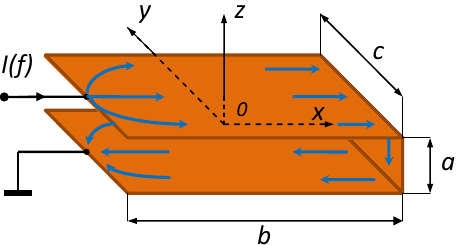
Figure 1. Schematic view of the "magnetic capacitor" excitation system. The arrows show the di- rection of the current in the electrodes.